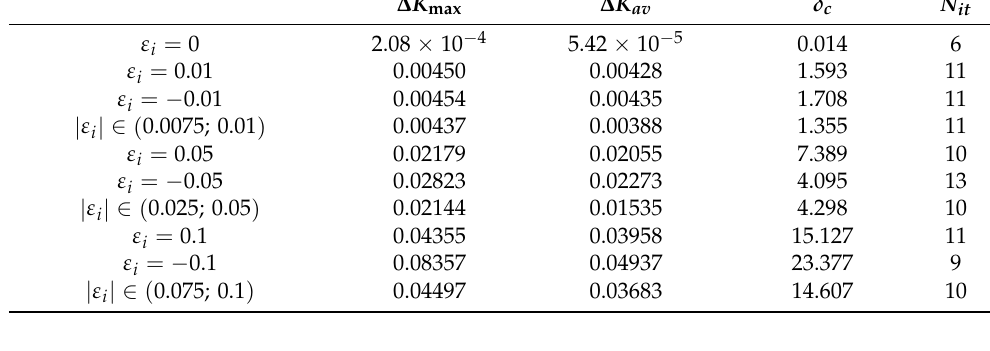
Table 3. The obtained results.